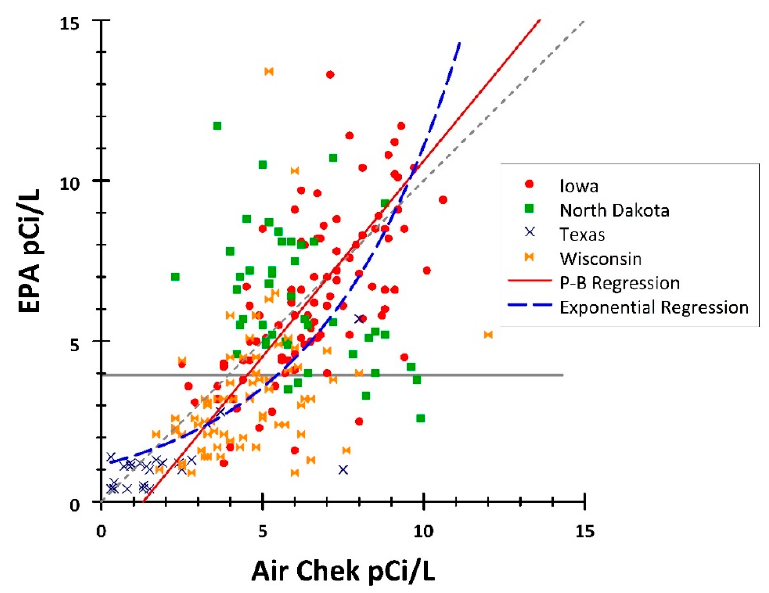
Figure 2. Scatterplot of Air Chek and EPA measures with Passing–Bablok and exponential regressions by state. Abbreviations: P-B Regression = Passing–Bablok regression.